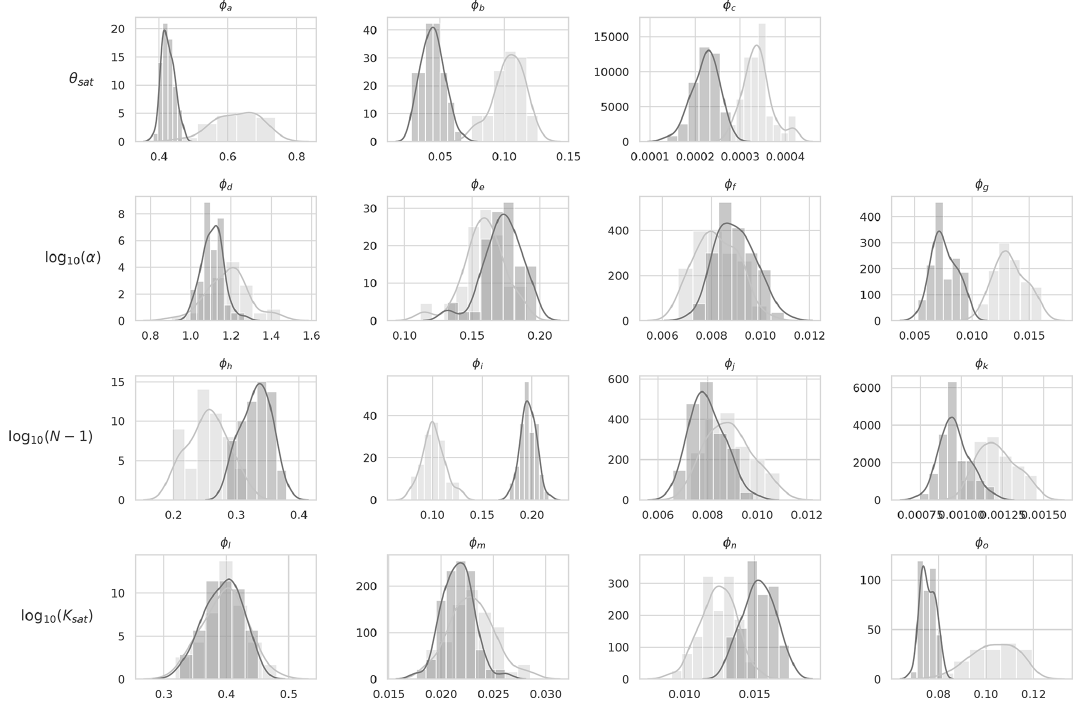
Figure 4. Distributions of prior and posterior pedotransfer function parameters grouped by the term in the equations (Eq. 1) that they relate to (see row labels). Light grey: parameter distribution for the prior ensemble; dark grey: parameter distribution for the posterior ensemble.